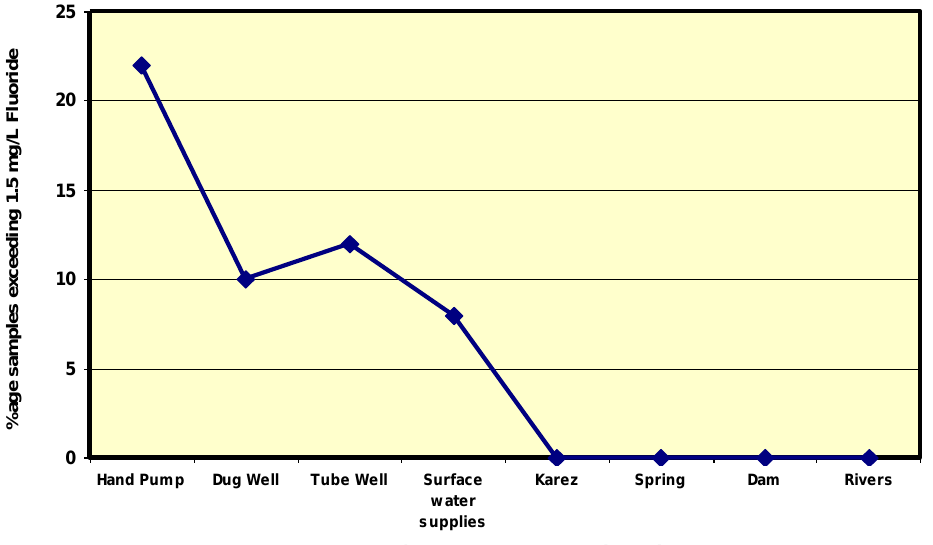
Figure-7: Distribution of fluoride in surface and groundwater sources Figure 7. Distribution of fluoride in surface and groundwater